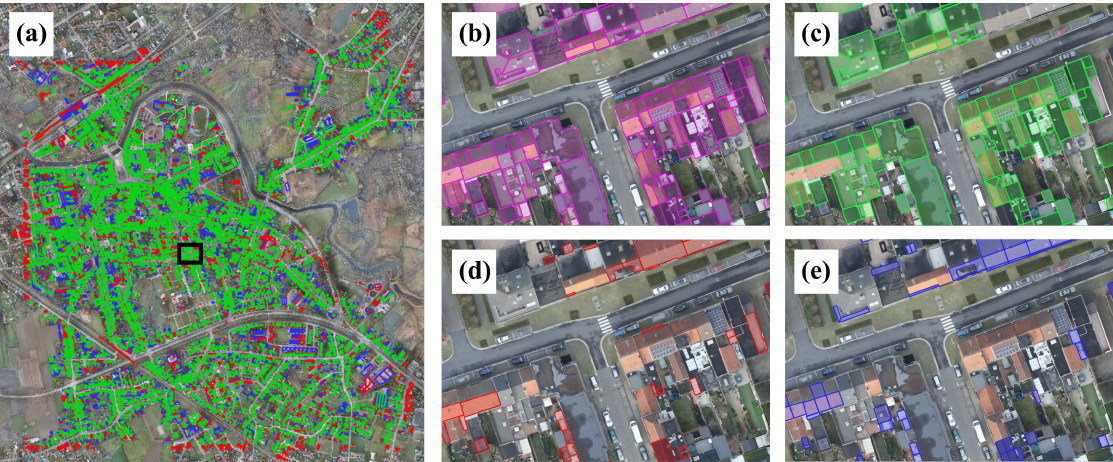
Figure 8. ( a ) Extracted polygon predictions for the whole test region. The black rectangle indicates the zoomed region in ( b – e ). ( b ) Roof-part polygon predictions. ( c ) True positives. ( d ) False positives. ( e ) False negatives.